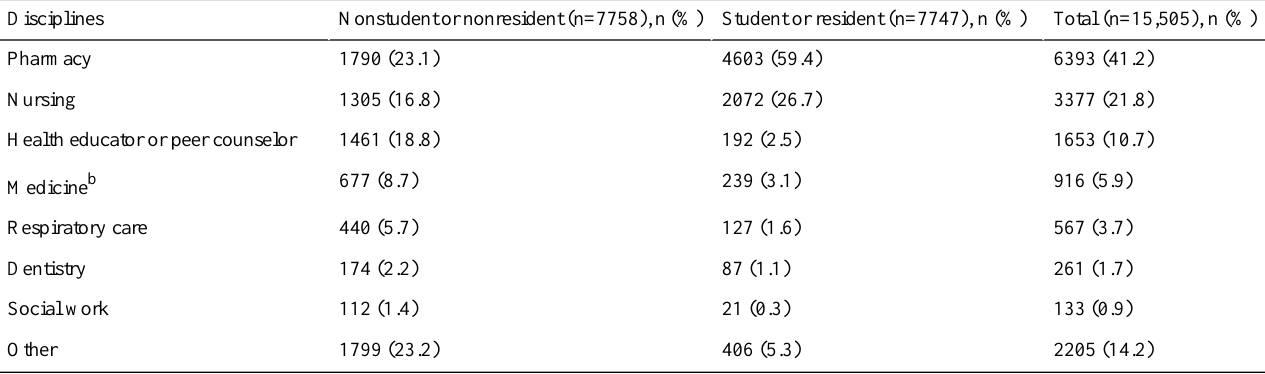
Table 1. Represented disciplines among 15,505 a end users reporting discipline and student or resident